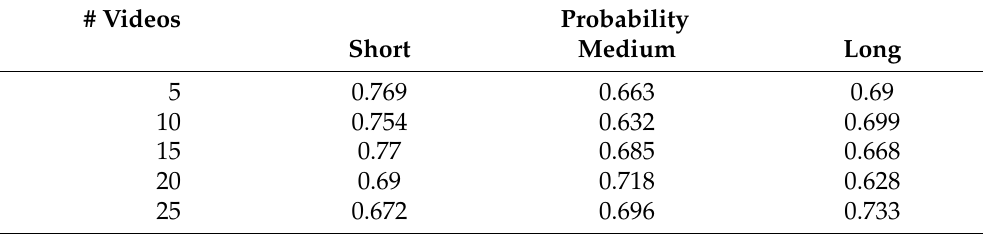
Table 4. Probability of quality downgrade events with variable number of